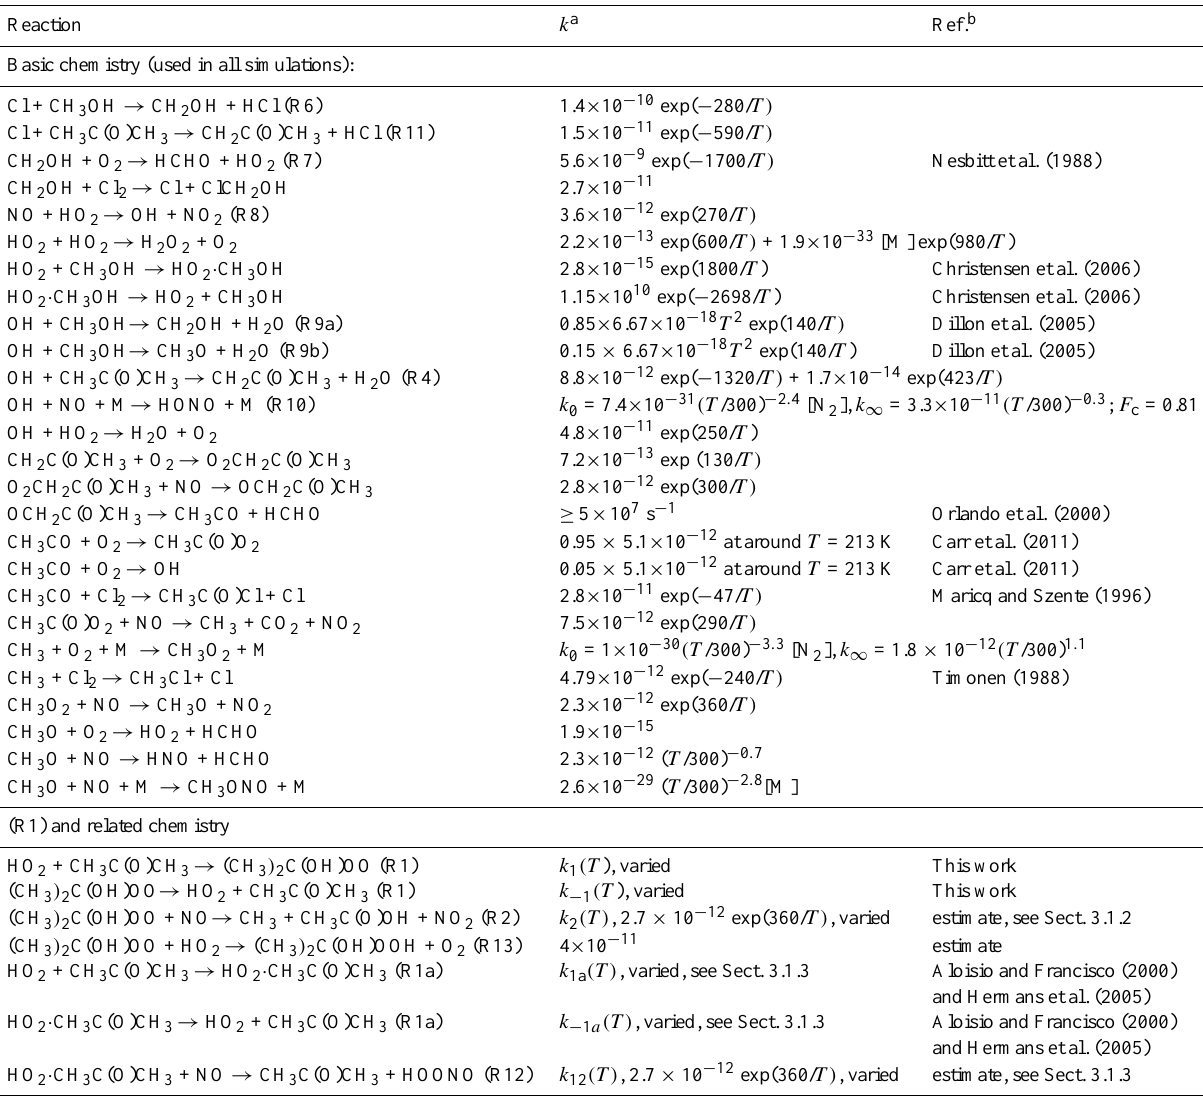
Table 3. Chemistry used in numerical simulations (Sect. 3.1.2). Reaction k a Ref.